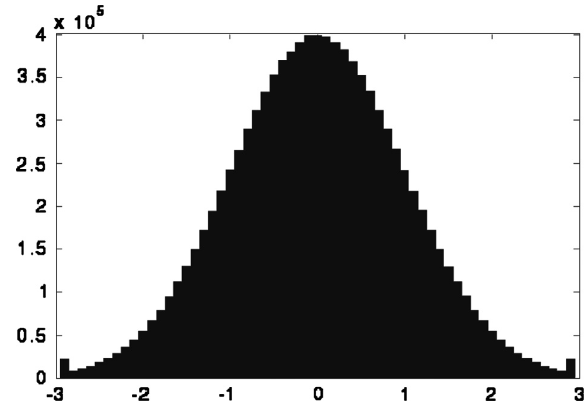
Figure 1. Normal distribution of 1e7 random numbers with mean 0 and variance 1.